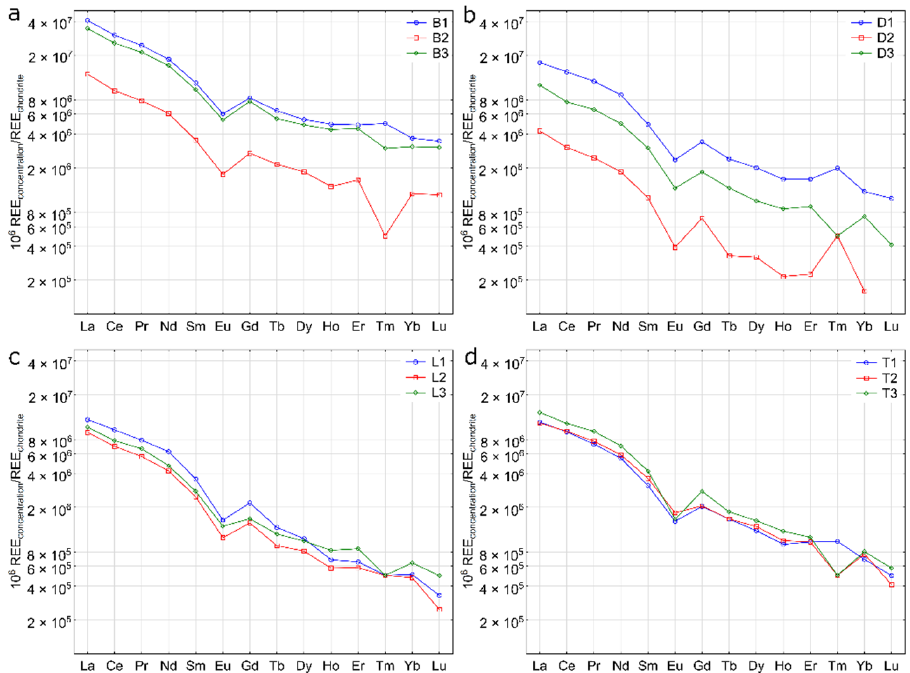
Figure 4. Normalized REE patterns using chondrite as a normalizer for bottom sediments of rivers located within the range of the: ( a ) Belchatow; ( b ) Drzewce; ( c ) Lubstów; and ( d ) Tomislawice mines. In the River Note ć near Lubstów pit mine, similar relationships were observed as